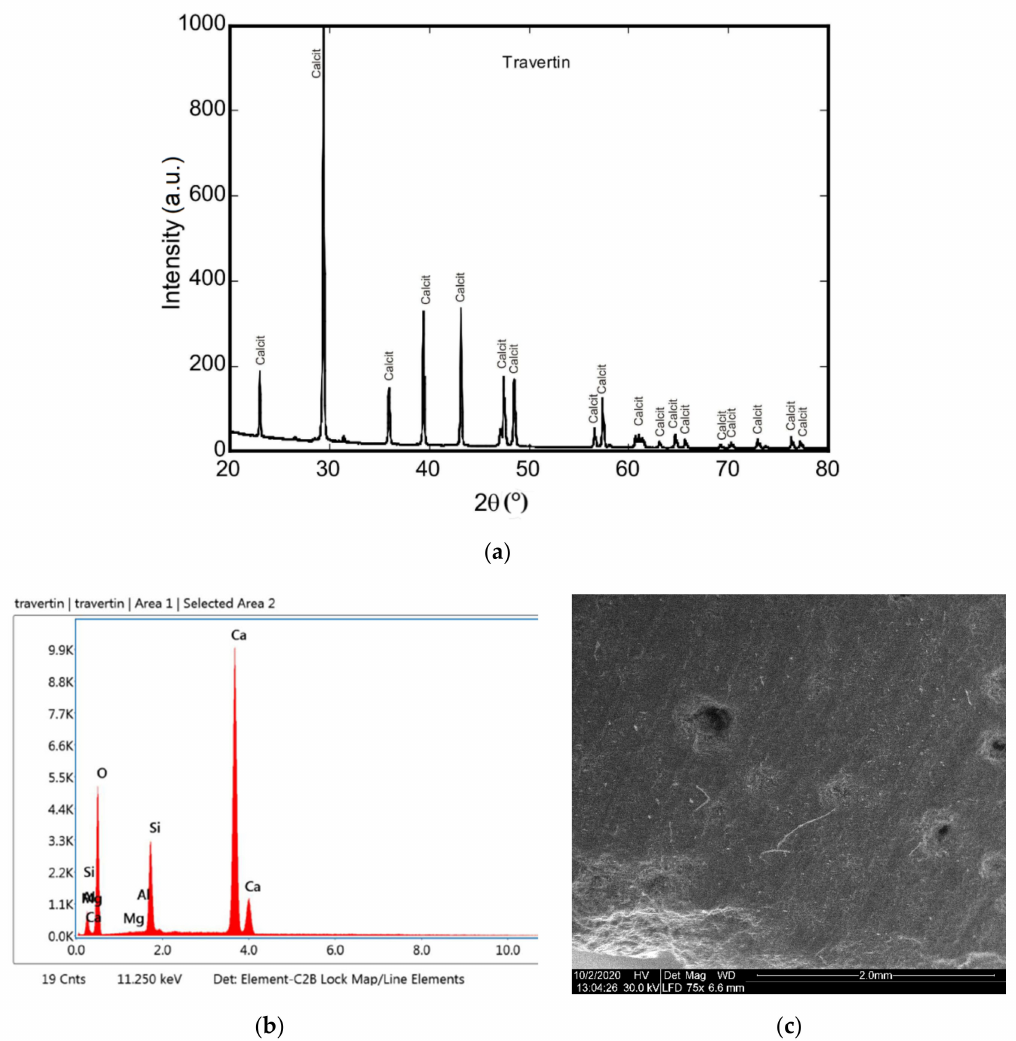
Figure 1. XRD travertine spectrum ( a ); SEM image of travertine commercial sample ( b ); EDX analysis of the same sample ( c